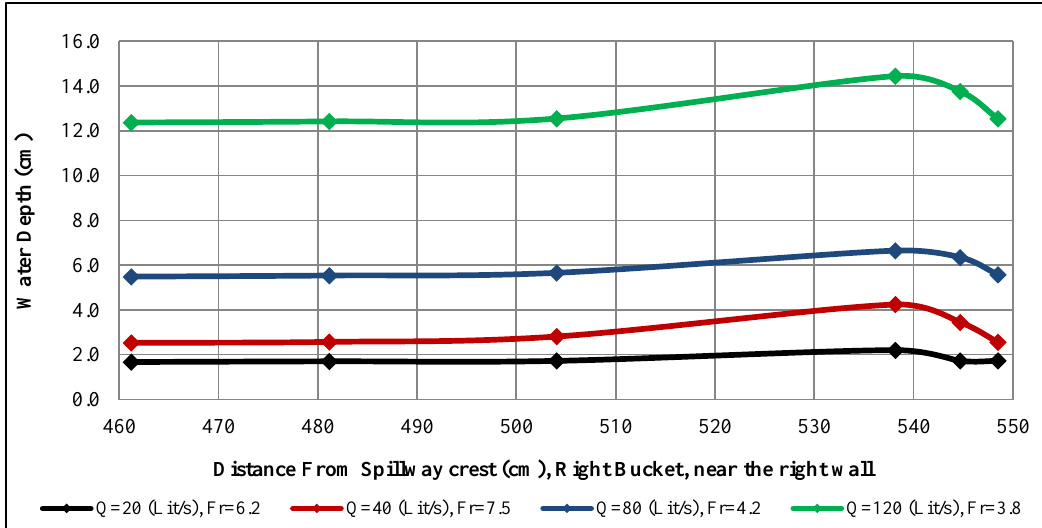
Figure 8. Variation of dynamic pressure on the right bucket near the right